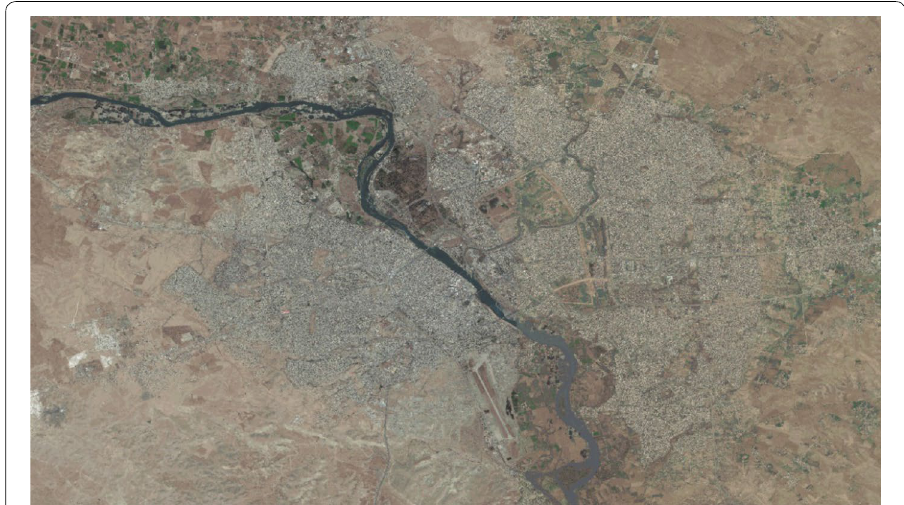
Fig. 8 Satellite image of Nineveh province in